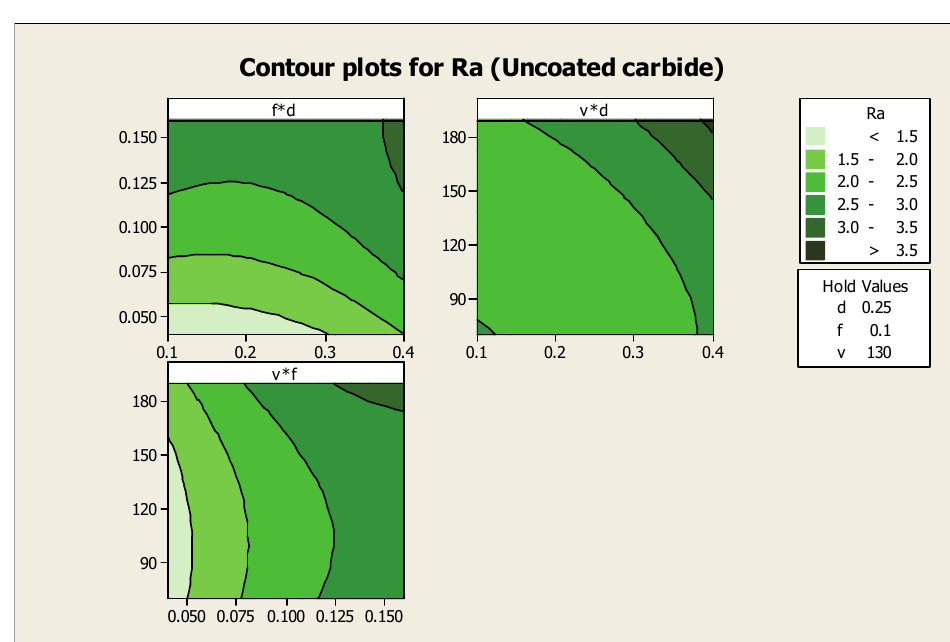
Fig. 13. Contour plots for surface roughness